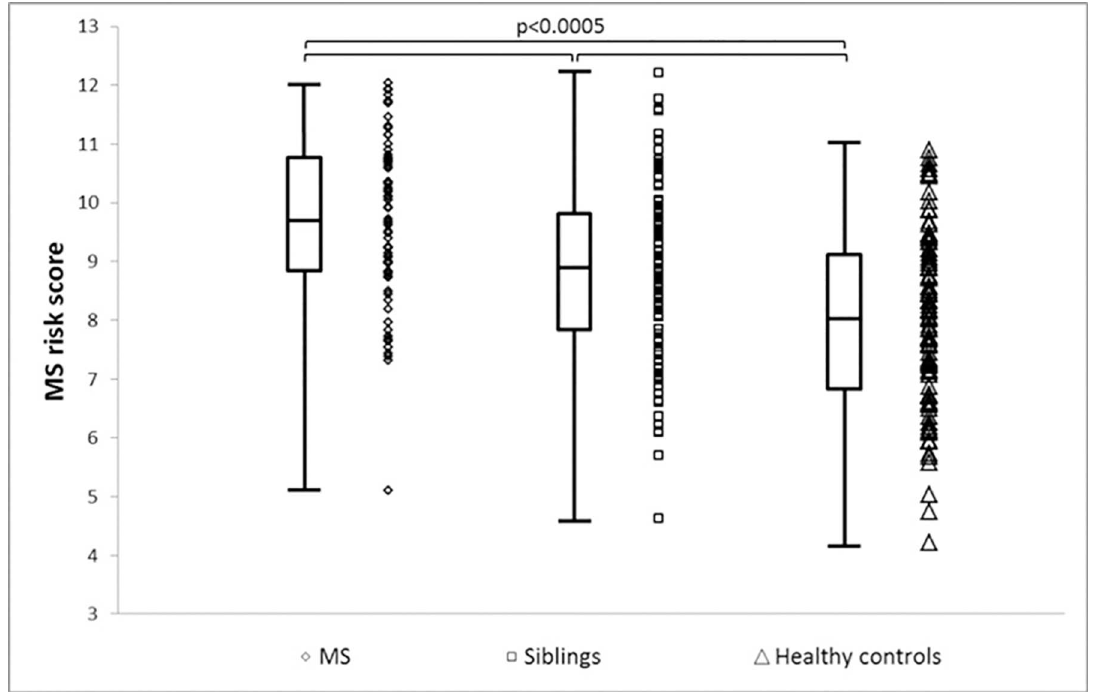
Fig 3. Combined scatter and box-and-whisker plot demonstrating the MS risk score distribution between people with MS and healthy controls. The box indicates the interquartile range, bisected by the median, and the whiskers the range. Full genetic informationis used to derive the MS risk